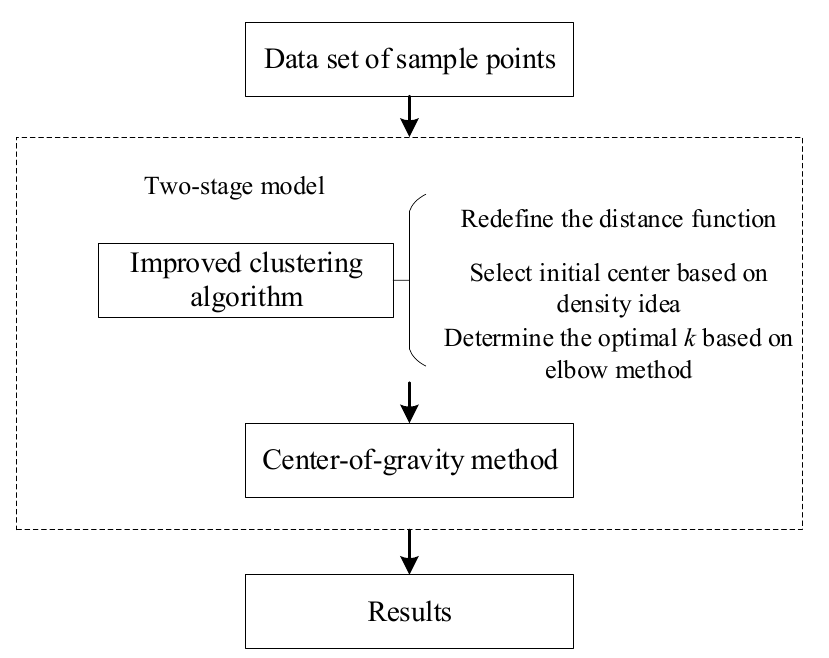
Figure 1. Framework of the proposed model.